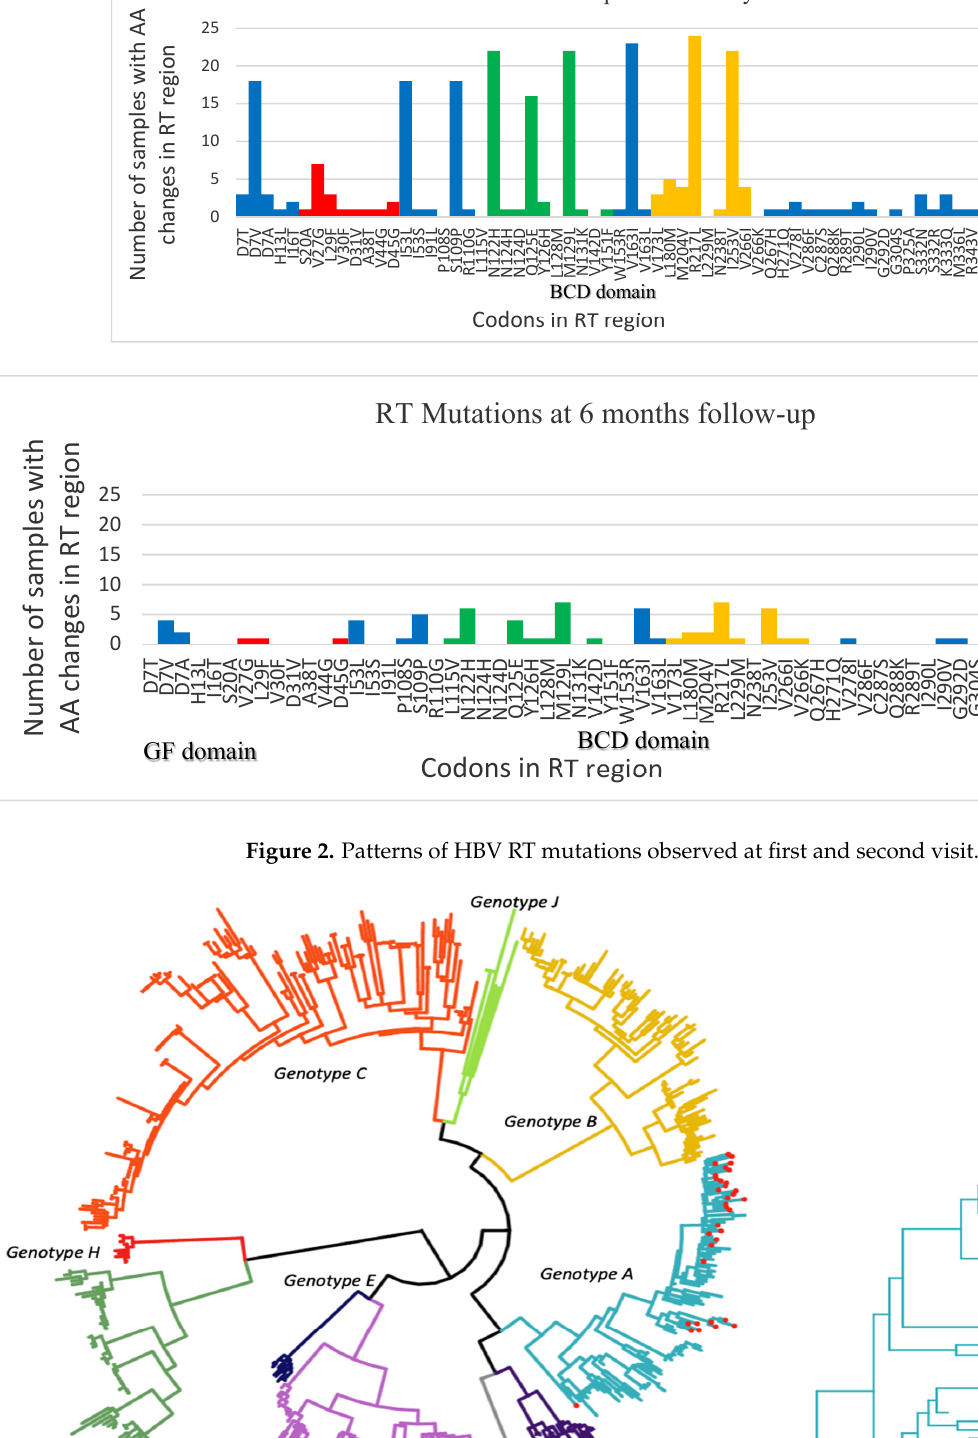
Figure 3. Maximum likelihood phylogenetic tree showing ten HBV genotype references and an ex- pansion of genotype A with study sequences represented by red dots. Booster support values (>0.95) for major branches. 4. Discussion In this study, we found a large proportion (35%) of participants with persistent HBV viraemia on long-term TDF + LAM HBV-active ART. This is concerning, considering that this treatment has a relatively high genetic barrier compared to other treatment regimens used for managing CHBV. A multi-centre study conducted in Australia and Thailand also reported similarly high rates of persistent viraemia in HIV/HBV co-infected patients on